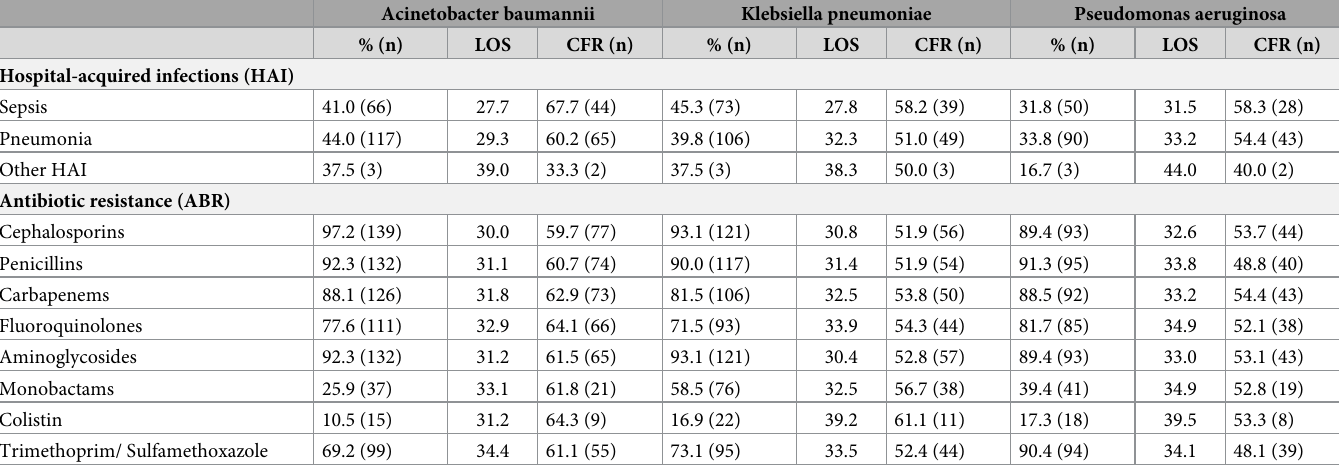
Table 3. Hospital-acquired infections with, and antibiotic resistance in Acinetobacter baumanii , Klebsiella pneumoniae and Pseudomonas aeruginosa in relation to treatment